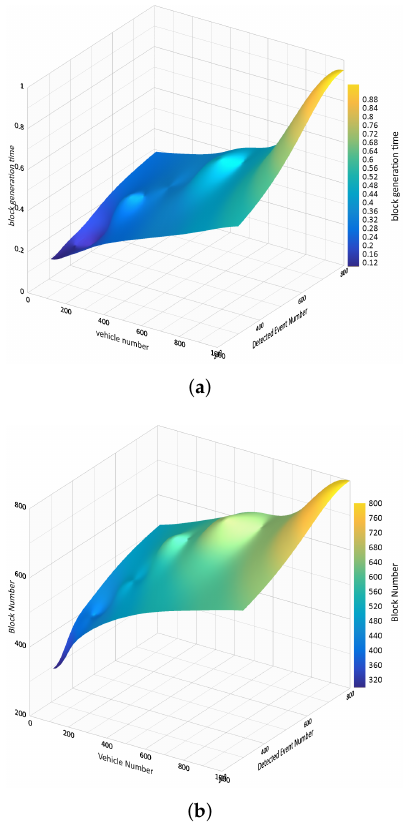
Figure 11. The effect of number of forwarded messages in the network on the number of blocks in the Blockchain and the required time to mine. ( a ) Required time to mine; ( b ) Number of blocks in the